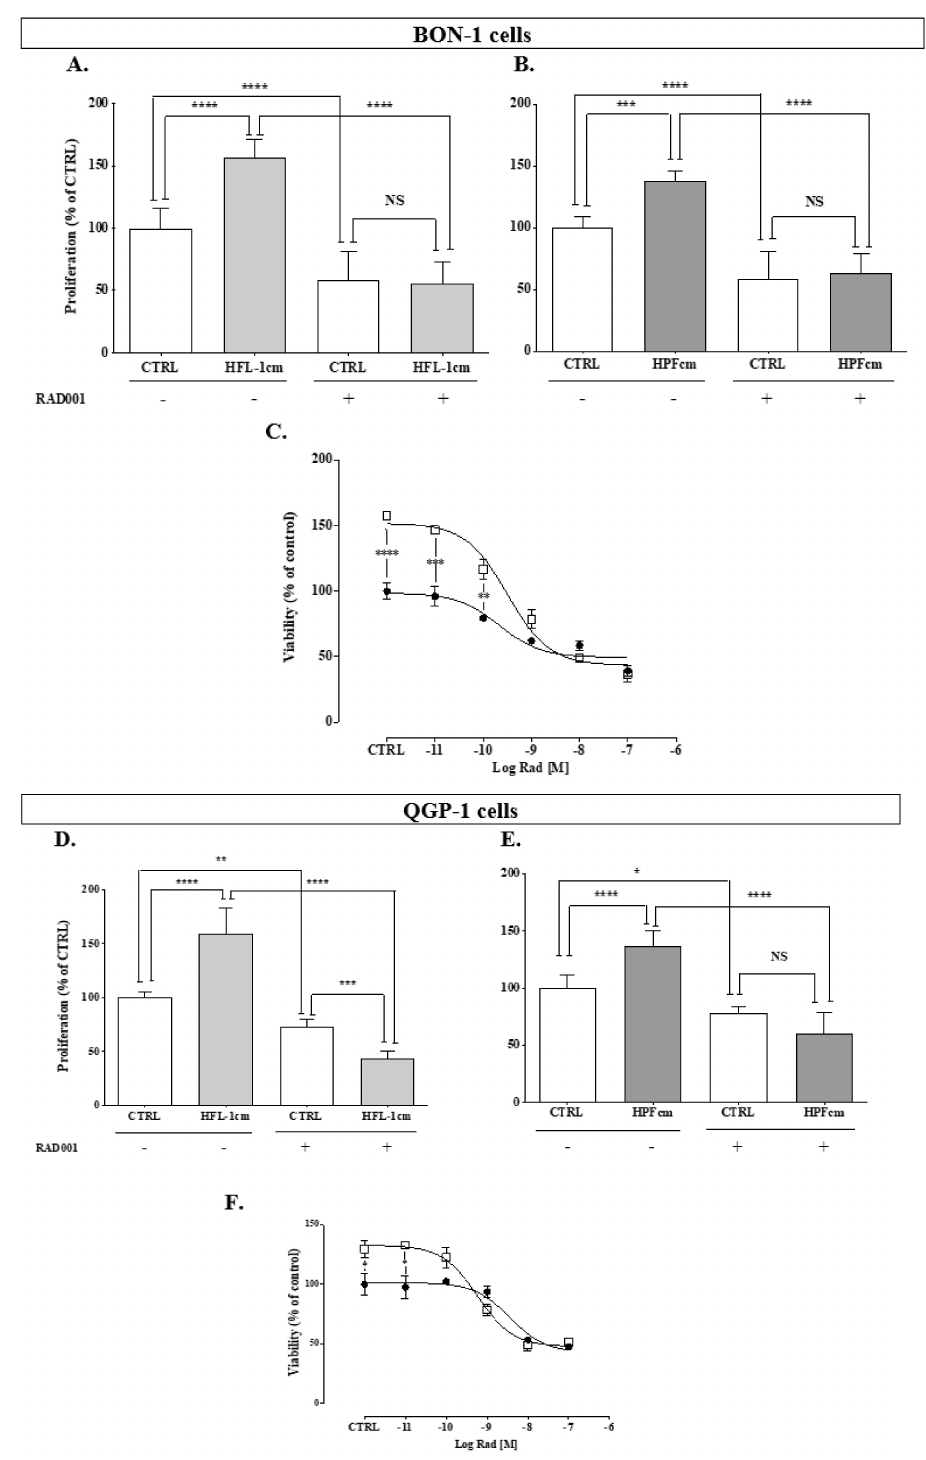
Figure 7. Effect of everolimus (RAD001) on the proliferation of human neuroendocrine cell lines. BON-1 cells were either not treated (CTRL) or treated with RAD001 at 1 nM in the presence of HFL-1cm ( A ) or HPFcm ( B ). Dose-efficacy curve for RAD001 over BON-1 incubated either with (empty squares) or without (solid circles) HPFcm ( C ). Effect of the drugs on the proliferation of QGP-1 incubated either with HFL-1cm ( D ) or HPFcm ( E ). Similarly, a dose-efficacy curve for RAD001 over QGP-1 incubated either with (empty squares) or without (solid circles) HPFcm is shown in panel ( F ). **** p < 0.0001; *** p < 0.001; ** p < 0.01; * p < 0.05; NS: not